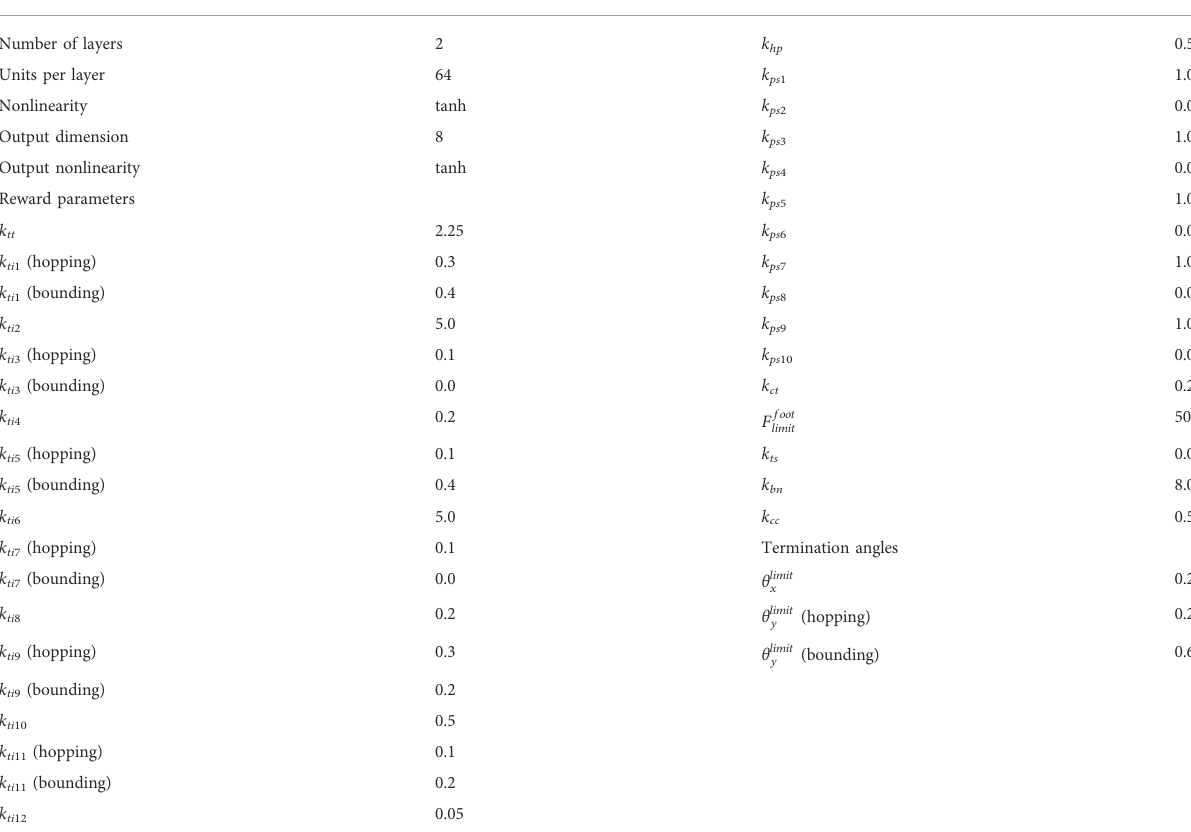
TABLE A1 Parameter values used in the training of the policies. Policy network (fully-connected) parameter Reward parameters